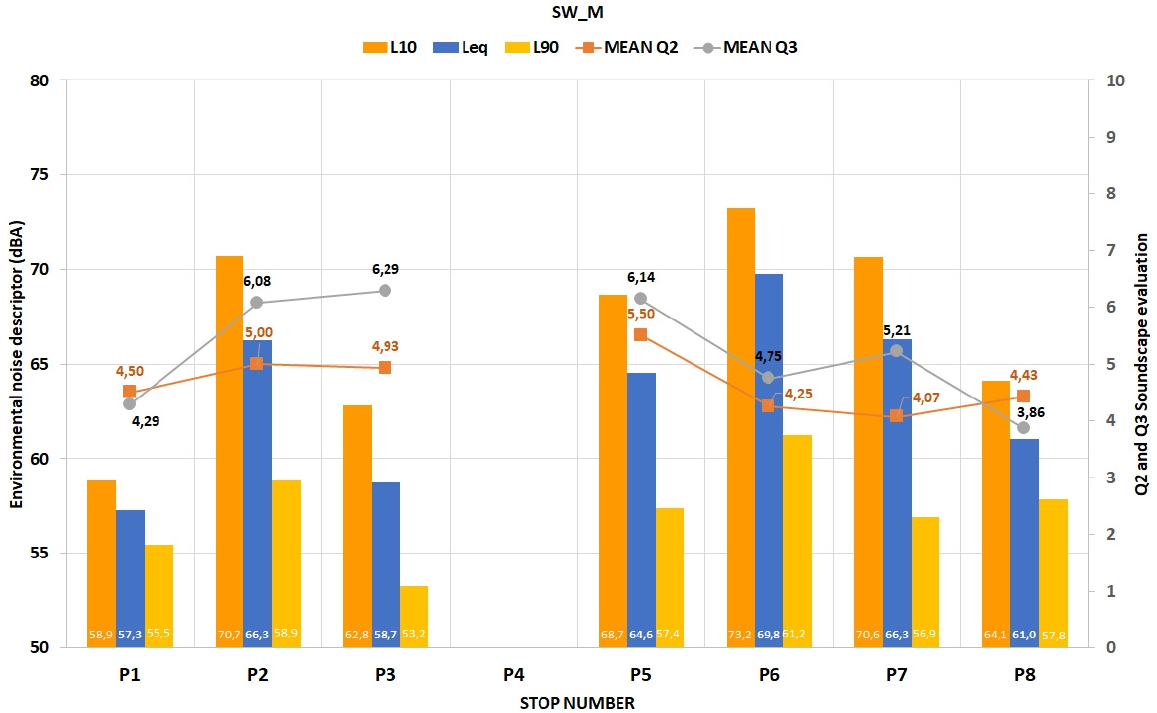
Figure 8: Mean Q2 and Q3 responses and coincident environmental noise characterisation (using LeqT, L10 and L90) at different stop sites during SW_M